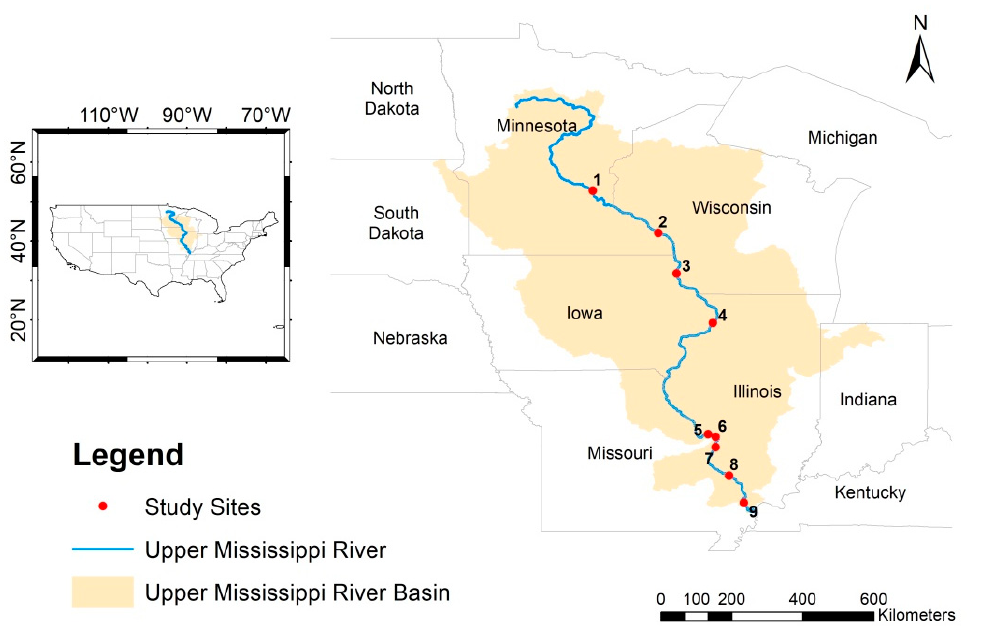
Figure 1. Study sites in the Upper Mississippi River. Table 1. General information and periods of available flow and sediment data (both suspended sediment concentration (SSC) and sediment discharge) for the nine Upper Mississippi River study sites shown in Figure 1. Source: https: // waterdata.usgs.gov / nwis /